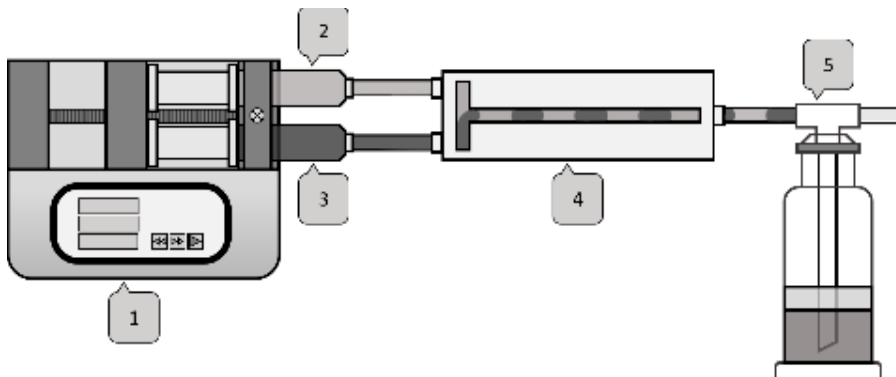
Figure 4. Fluid set-up: syringe pump #1, syringe with acetone and toluene #2, syringe with water #3, microchannel #4, waste container with mineral oil as diffusion barrier #5.